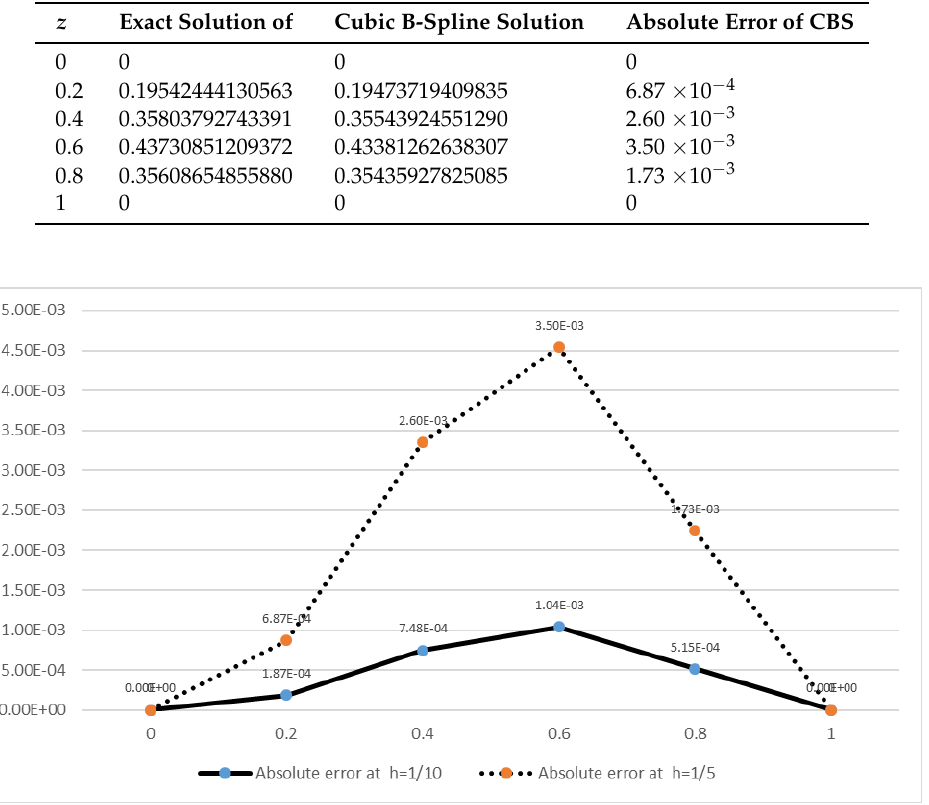
Figure 2. Graphical comparison of Problem 2 at h = 1